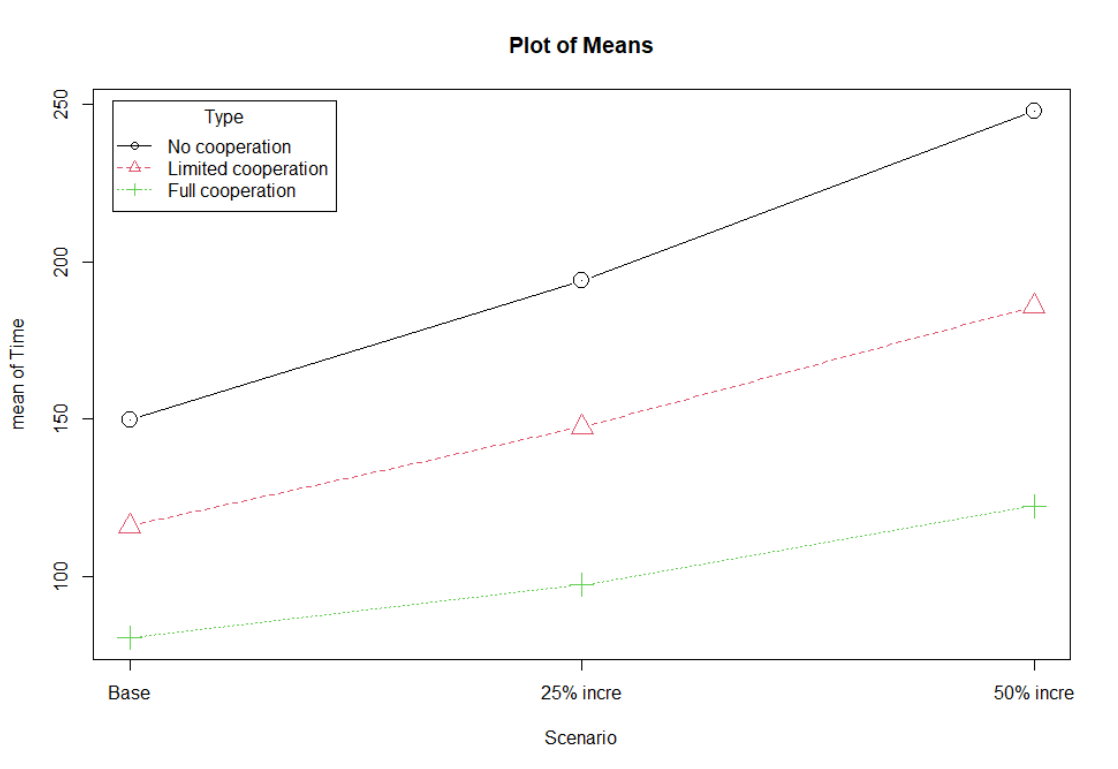
Figure 12. Mean plots by demand scenario and cooperative setting for average lead